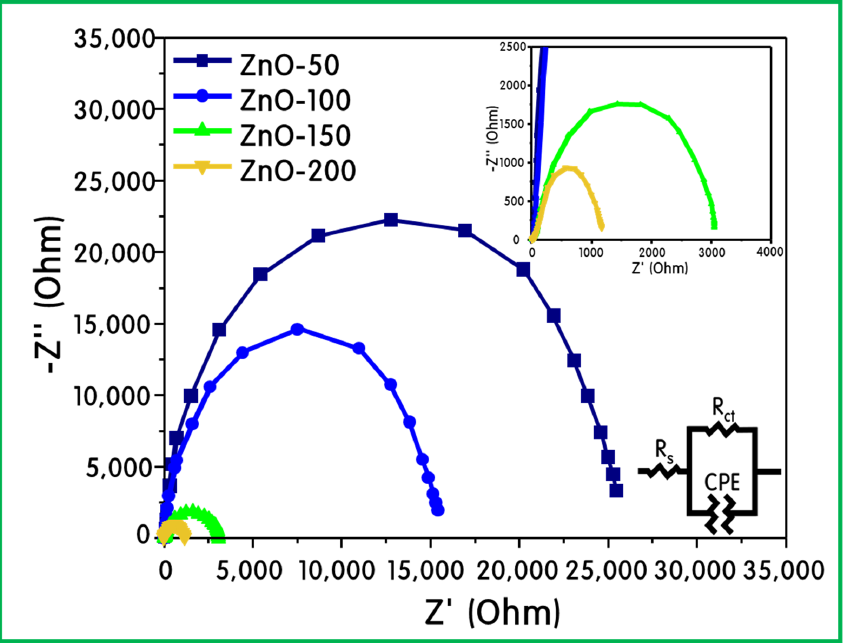
Figure 9. Electrochemical impedance spectra of ZnO-50, ZnO-100, ZnO-150, and ZnO-200 samples and its equivalent circuit.